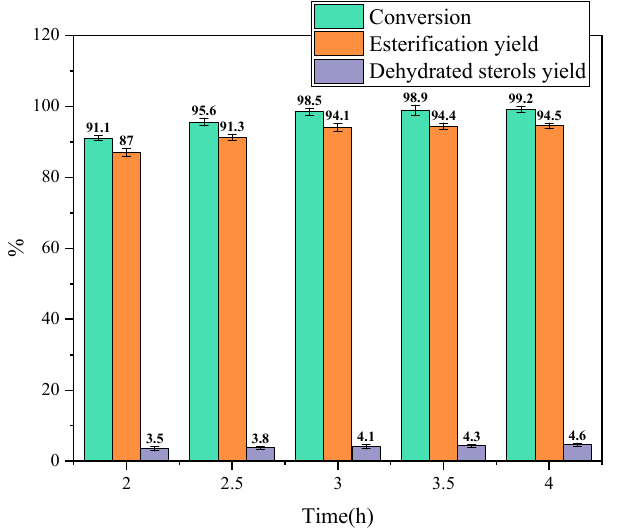
Figure 5. Effect of reaction time. Reaction conditions: 2 mmol pine sterols, 3 mmol oleic acid, 1.5% catalyst (based on the mass of pine sterols), 120 °C.